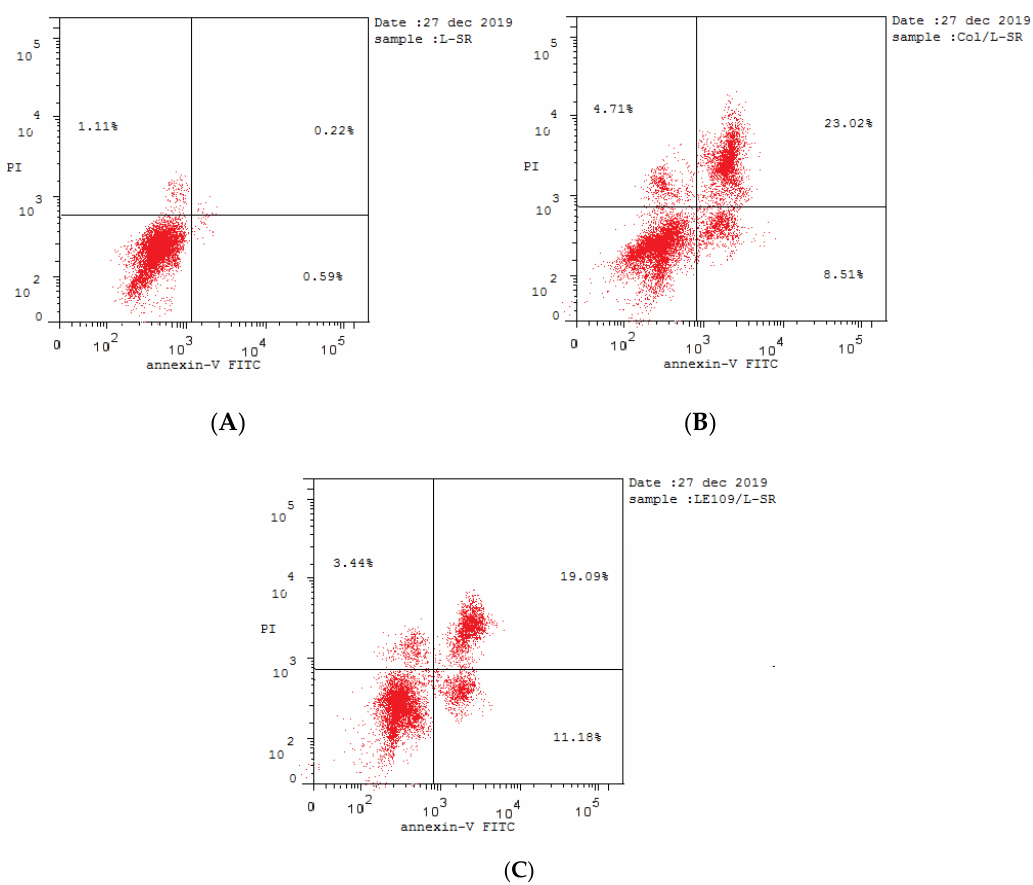
Figure 11. Contour diagram of annexin V / PI flow cytometry against SR cancer cell line. ( A ) Untreated cells; ( B ) treated cells with colchicine; ( C ) treated cells with 3a . The test was repeated three times. Following incubation for 24 h, cells were analyzed by flow cytometry after double staining with annexin V / PI.